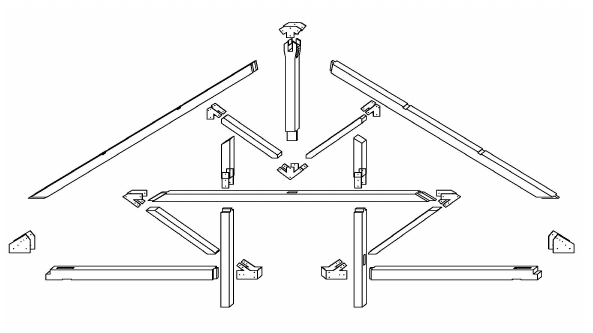
Figure 9. King Post component model, examples